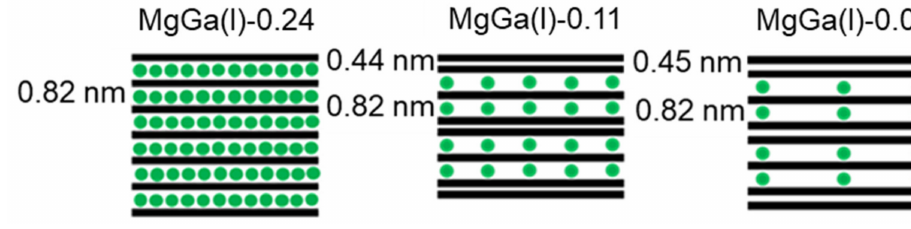
Figure 2. Proposed structure images of MgGa(I)-x (x = 0.24, 0.11, and